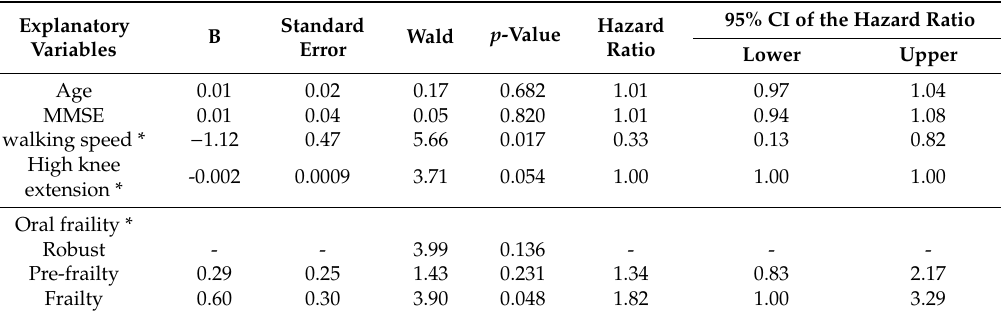
Table 5. Factors related to social